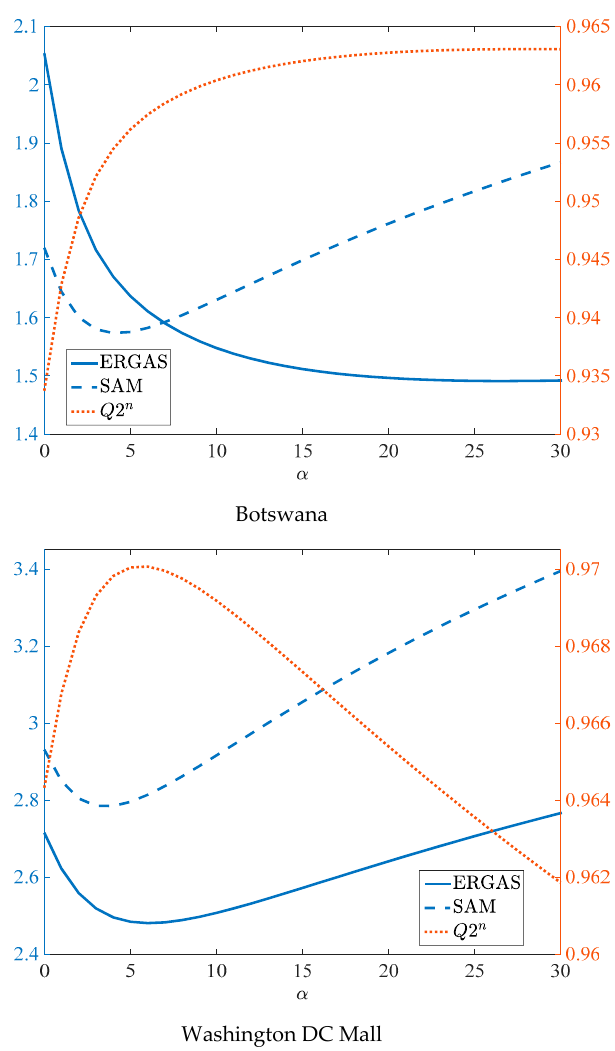
Figure 3. The values of the performance metrics versus the regularization parameter α for the experiments with Botswana and Washington DC Mall images. The left y -axis corresponds to ERGAS and SAM and the right y -axis to Q 2 n .